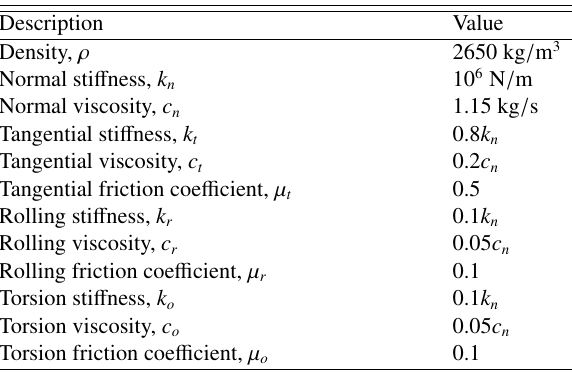
Table 1: DEM parameters